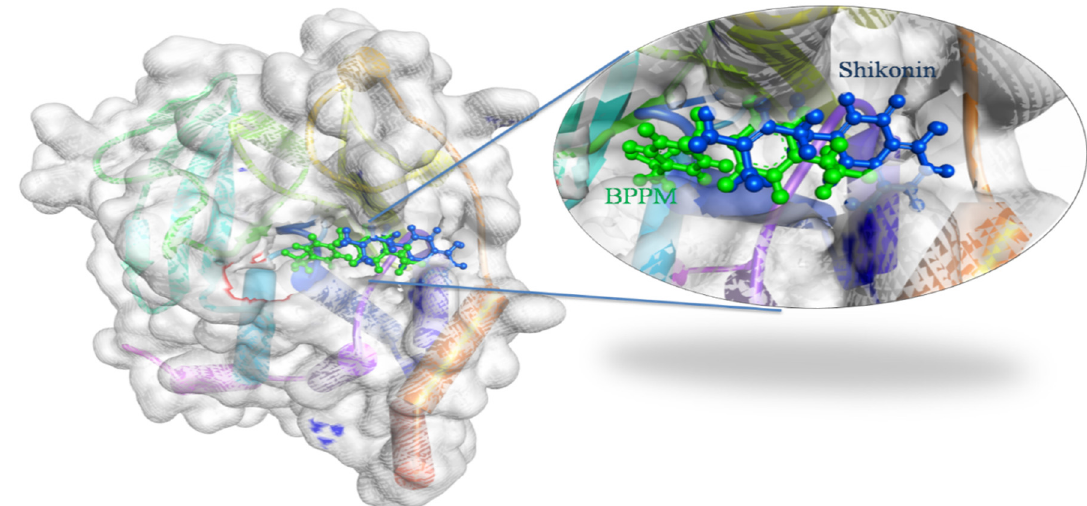
Figure 1. Docking view of Shikonin in the binding sites of PTP1B (PDB ID: 1AAX). On the left side is the surface view of the docked complex-Shikonin and 1AAX, on the right side, a binding pocket is magnified to present Shikonin (shown in the blue-colored ball and stick view) superimposed on the co-crystal ligand-BPPM (shown in the green-colored ball and stick view). Diagrams are prepared in the Biovia Discovery Studio.